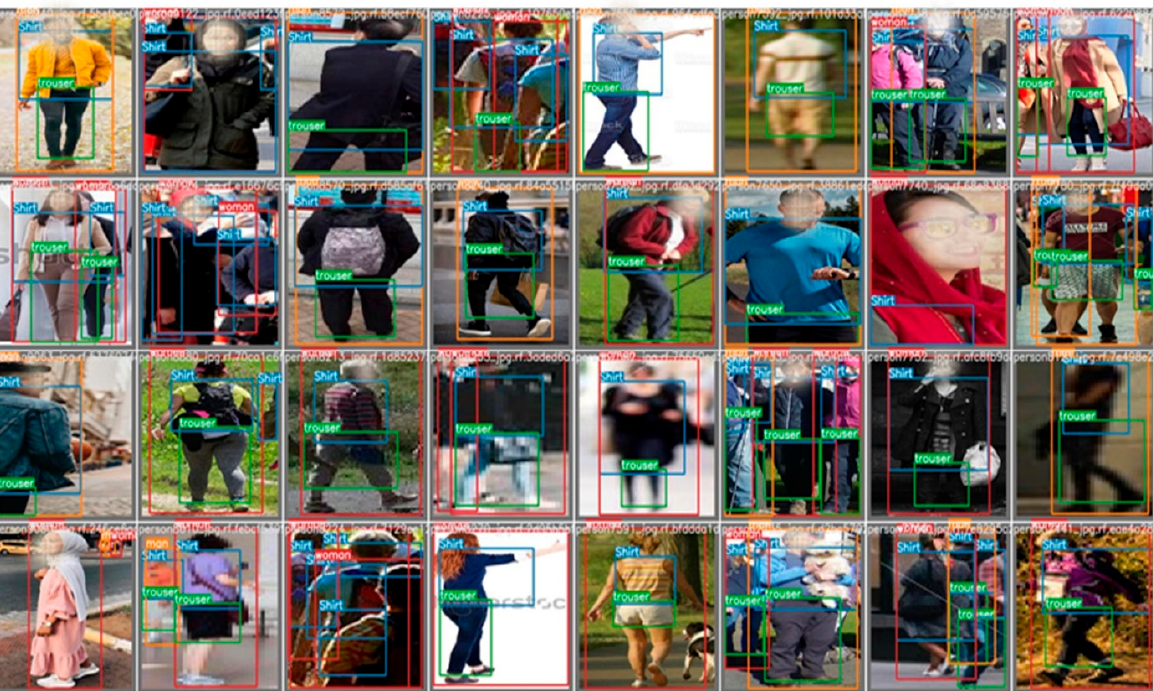
Figure 3. Images sample taken randomly from our dataset by Scaled Yolov4 to use in the training step; we did not choose any of them. These images prove the diversity of the PGC dataset, and it contains women, men, Arab women, Asian women, Black men, crowded scene, a single person scene, bluer scene, indoor scene, outdoor scene, back view, and front view.